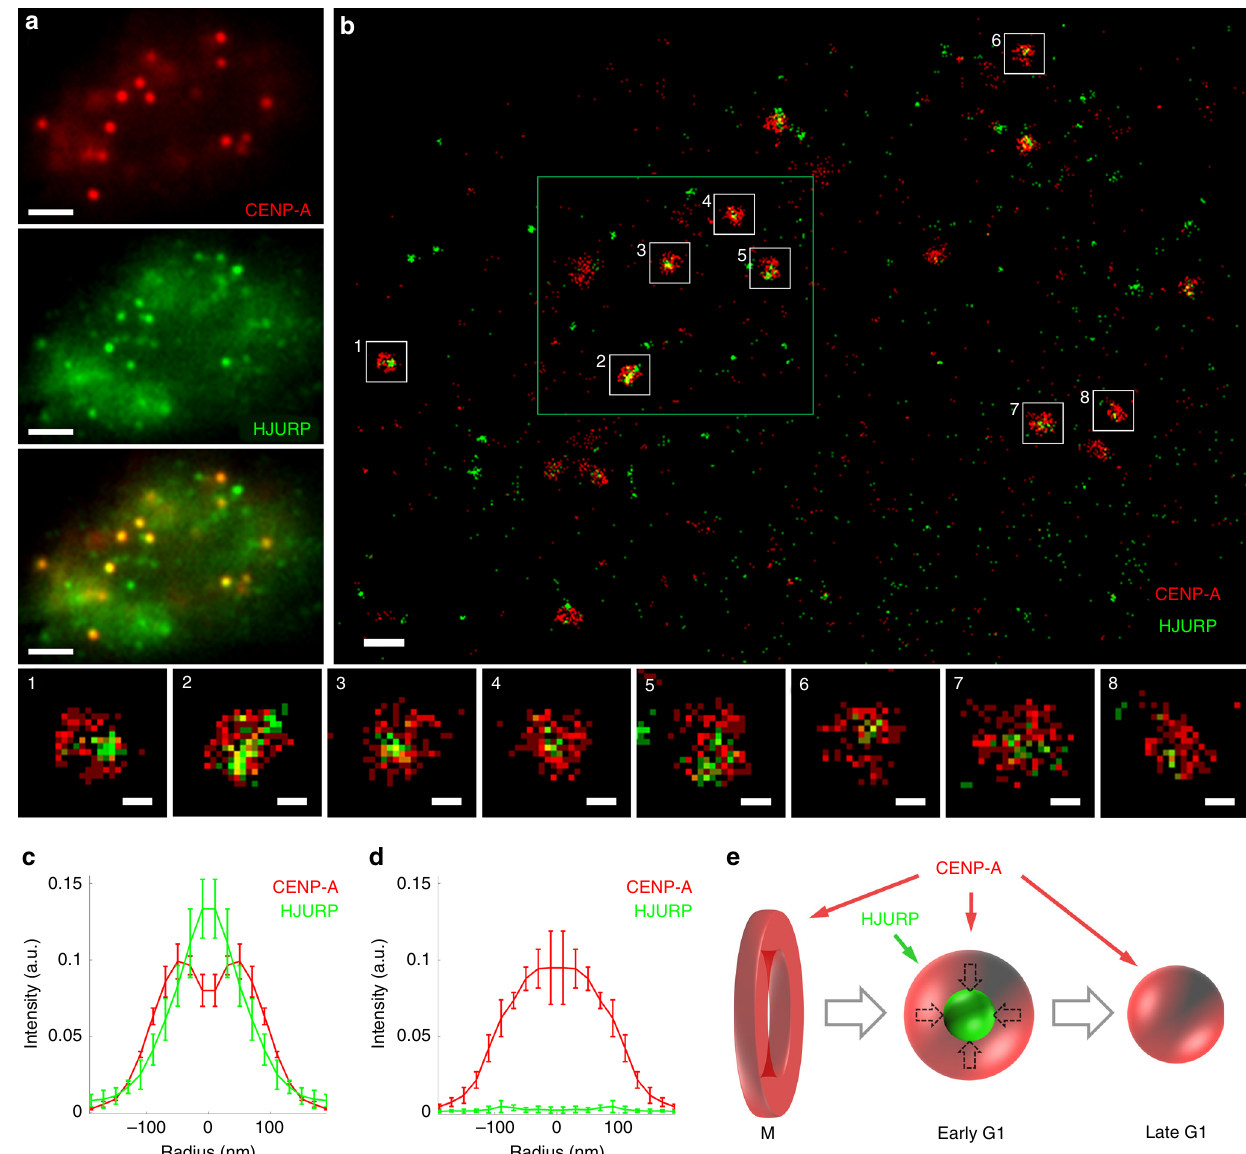
Fig. 4 SMLM imaging of CENP-A with its chaperone HJURP (U2OS cells). a Wide- fi eld images of CENP-A and HJURP show their overall co-localization at centromeres. b SMLM imaging demonstrates that CENP-A (red) and HJURP (green) form clusters of different shapes in which CENP-A and HJURP do not co-localize at the individual molecule level. Bottom left panels 1 – 8: magni fi ed centromeres from image ( b ) demonstrate that an HJURP cluster is primarily situated in the empty center of a CENP-A cluster. The dSTORM images (panels b and 1 – 8) are reconstructed in the histogram mode with a bin size of 20 nm. The green rectangle in panel ( b ) indicates the region that is zoomed in and displayed as a Voronoi diagram in Supplementary Fig. 7. Scale bars, 2 µ m ( a ), 500 nm ( b ), and 100 nm (1 – 8); for similar experiments using STED imaging see Supplementary Fig. 8. c , d Radial pro fi les of the rotationally averaged images of the CENP-A and HJURP particles at 1.5 h ( c ) and 5 h ( d ) after mitosis, using fi ve cells for each time point; see Source Data fi le. e Schematic description of the evolution of the shape of CENP-A clusters during the cell fl uorophore. For counting of the relative number of CENP-A localizations Data processing . The localization and fi tting of single-molecule events were per- formed in real time during acquisitions in Leica LAS AF software with the “ direct fi t ” (Supplementary Fig. 3), each cell was imaged with exactly the same experimental fi tting method. The localization tables were then exported for further processing in parameters. For DNA visualization with YoYo-1 dye, blinking was not as strong, the SharpViSu software work fl ow 40 and with customized Matlab procedures. The which may explain the lower resolution obtained compared with Alexa dyes; however, showing chromatin decondensation (Supplementary Fig. 13) does not drift was detected and corrected in two or three dimensions, for 2D and 3D data, require high resolution. respectively, using cross-correlation-based approach. Brie fl y, the data set was divided STED microscopy was done on a Leica TCS SP8 STED 3X microscope with the on several consecutive subsets, from each of them a histogram image with pixelation HC PL APO CS2 100×/1.40 OIL objective. The fl uorophores were excited with a of 20nm was built, and the shift between these images was detected with subpixel supercontinuum laser at 15% of its maximal power. Alexa Fluor 488 was depleted precision and interpolated linearly throughout intermediate frames. The shift value with a 592 nm continuous-wave laser set at 70 – 90% of its maximal power. Alexa was then subtracted from the coordinates of every frame. The lateral drift was Fluor 555 was depleted with a 660 nm continuous-wave laser set at 75% of its detected using the projection on the XY plane, and the axial drift (for 3D data) was maximal power. The fl uorescence was detected with the HyD detectors working in detected using the average shift, calculated from the XZ and YZ projections. The the photon counting mode with time gating, detecting light from 0.5 to 6.0ns after procedure was repeated iteratively several times assuring absence of detectable resi- the excitation laser pulse. dual drift. Chromatic aberrations were fi rst calibrated using 0.2µm TetraSpeck ™